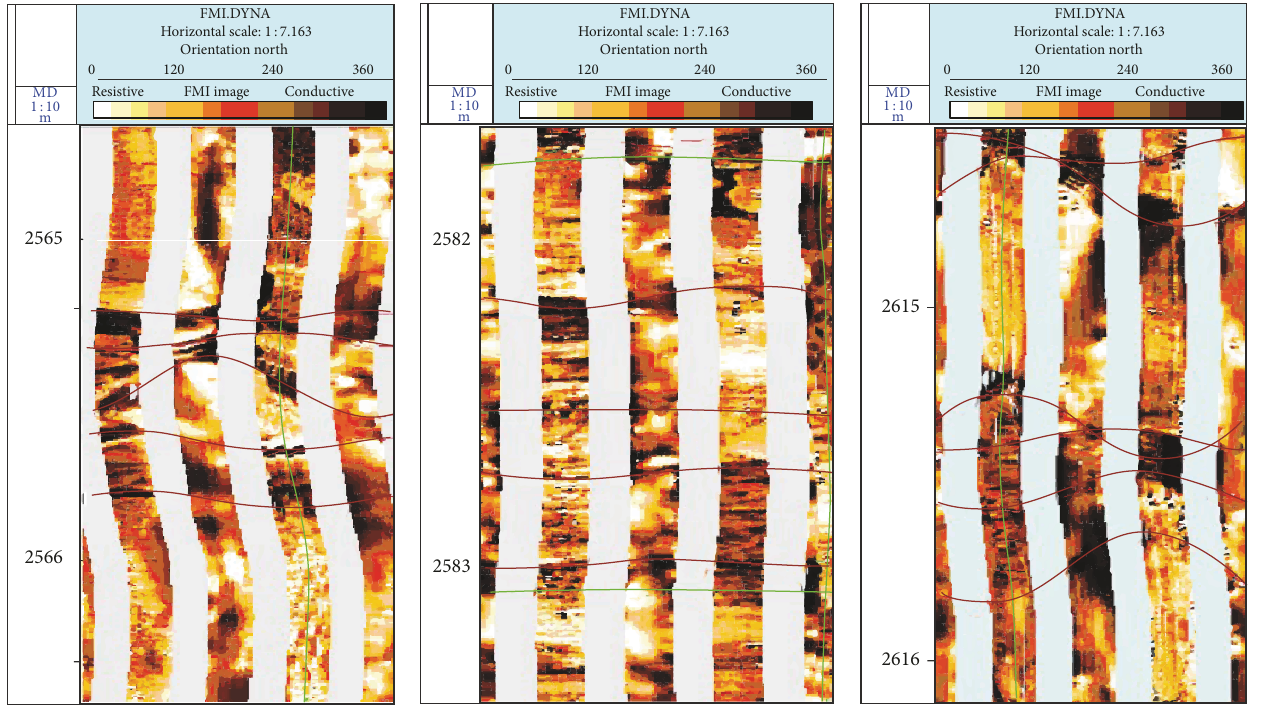
Figure 7: Depth imaging log in PL 113 well.